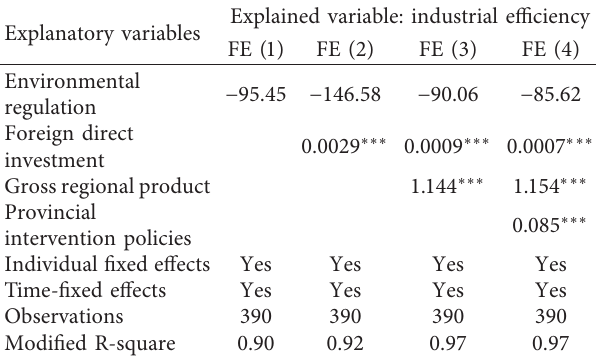
Table 5: Baseline model (fixed effects) estimation